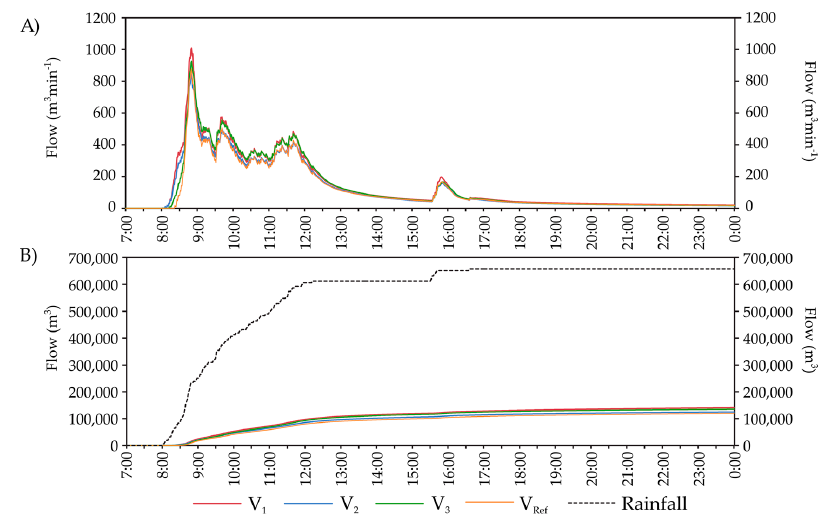
Figure 7. Simulated ( A ) flow time series and ( B ) flow accumulation for the Vesijärvi catchment for the parameter sets V 1 , V 2 , V 3, and V Ref (Event rainfall depth 22.0 mm, peak intensity 1.73 mm/5 min).